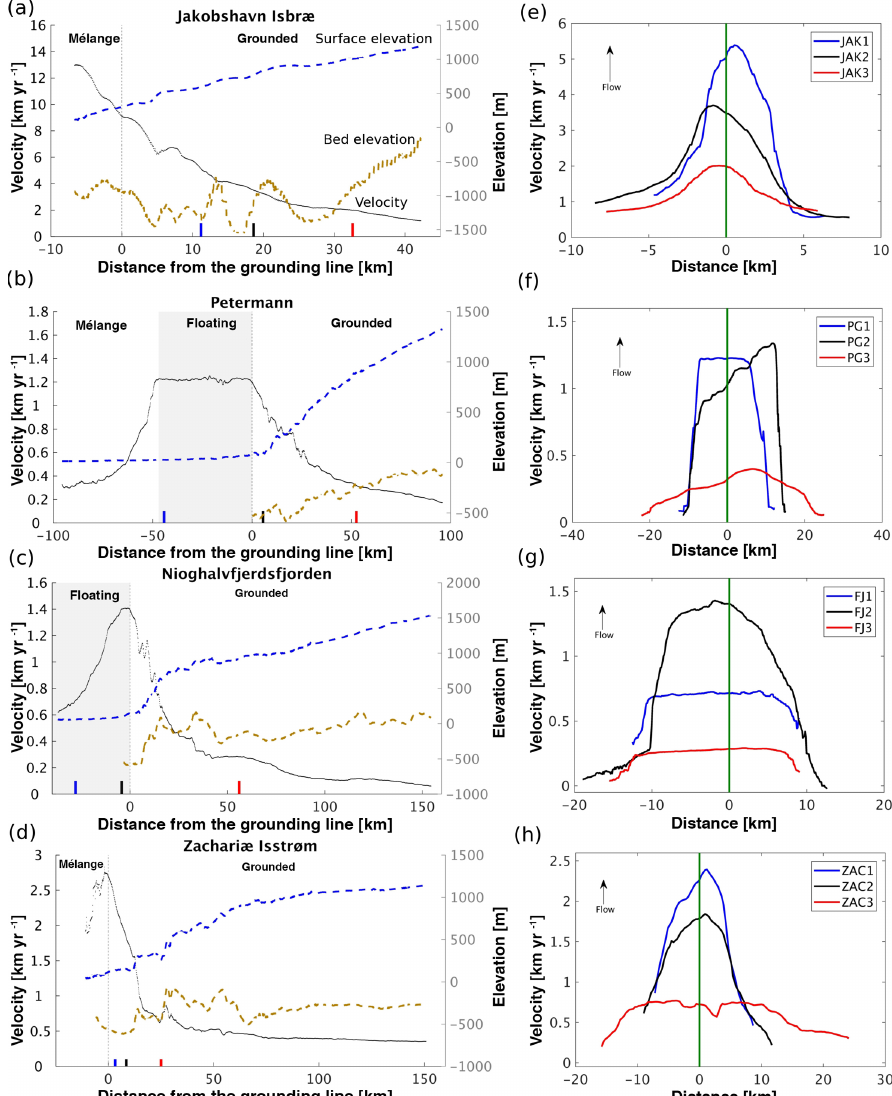
Figure 2. Average velocities (2014–2017) extracted from along- and across-flow profiles of Jakobshavn Isbræ, Petermann Glacier, Nioghalvf- jerdsfjorden, and Zachariæ Isstrøm. Panels (a–d) present along-flow profiles of ice velocity (solid black lines), surface elevation from the GIMP DEM (Howat et al., 2014; dashed blue lines) and bed elevation from the IceBridge BedMachine Greenland V2 product (Morlighem et al., 2015; dashed yellow lines). The location of each profile is shown in Fig. 1 (green lines). The grey shaded area represents the floating regions, and the light grey dashed line the ice front positions. The blue, black, and red markers represent the locations of the across-flow profiles. (e–h) show the across-flow velocity profiles (solid white lines in Fig. 1), centred on the main profile (solid green line).